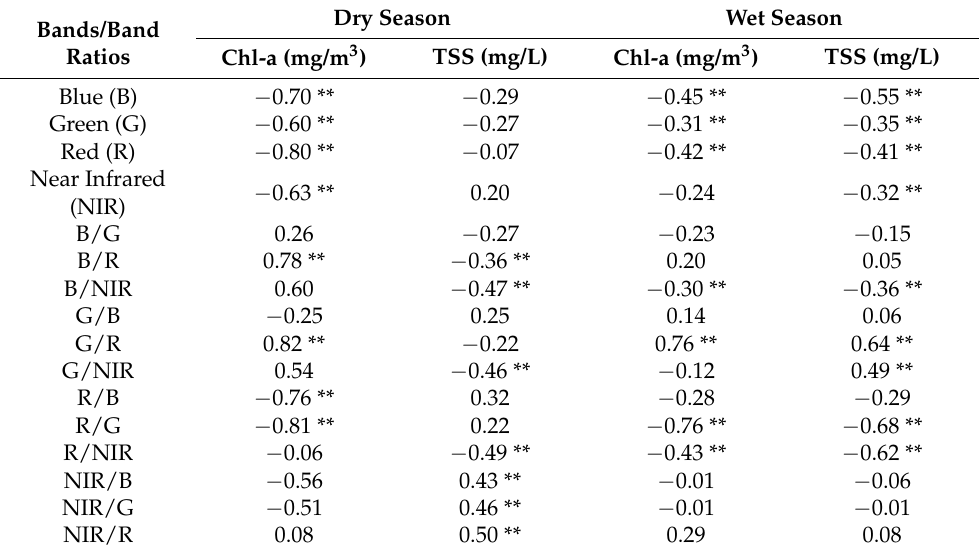
Table 2. Pearson’s R correlation between limnological data and Landsat bands and ratios. Dry Season Wet Season Bands/Band Ratios Chl-a (mg/m 3 ) TSS (mg/L) Chl-a (mg/m 3 ) TSS (mg/L) Blue (B) − 0.70 ** − 0.29 − 0.45 ** − 0.55 ** Green (G) − 0.60 ** − 0.27 − 0.31 ** − 0.35 ** Red (R) − 0.80 ** − 0.07 − 0.42 ** − 0.41 ** Near Infrared − 0.63 ** 0.20 − 0.24 − 0.32 ** (NIR) B/G 0.26 − 0.27 − 0.23 − 0.15 B/R 0.78 ** − 0.36 ** 0.20 0.05 B/NIR 0.60 − 0.47 ** − 0.30 ** − 0.36 ** G/B − 0.25 0.25 0.14 0.06 G/R 0.82 ** − 0.22 0.76 ** 0.64 ** G/NIR 0.54 − 0.46 ** − 0.12 0.49 ** R/B − 0.76 ** 0.32 − 0.28 − 0.29 R/G − 0.81 ** 0.22 − 0.76 ** − 0.68 ** R/NIR − 0.06 − 0.49 ** − 0.43 ** − 0.62 ** NIR/B − 0.56 0.43 ** − 0.01 − 0.06 NIR/G − 0.51 0.46 ** − 0.01 − 0.01 NIR/R 0.08 0.50 ** 0.29